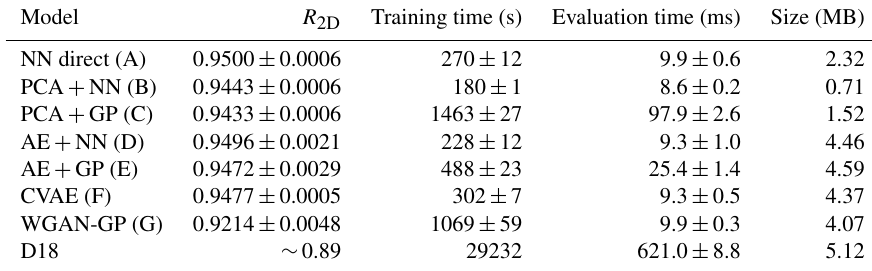
Table 1. The 2D correlation coefficient R 2D (as defined in Eq. 12), training time, single likelihood evaluation time, and total size of the model for all our models and the model of Das et al. (2018, D18). The capital letter in round brackets refers to the schematic in Fig. 3. Note that training time refers to the total time to preprocess, train, and postprocess data. All of our experiments were run on an Intel ® Core™ i7-8750H CPU @ 2.20GHz, which can be found on an average-performing laptop. Results for D18 are taken from Table 2 and Fig. 14 in D18 and have been run in parallel on an HPC cluster, with the only exception of the likelihood evaluation time, which we performed on our machine. The reported values of R 2D and times are the mean and standard deviation of three runs. All of our proposed models perform better than the one shown in D18, while taking considerably less time and requiring less disk space and hardware performance. Model R